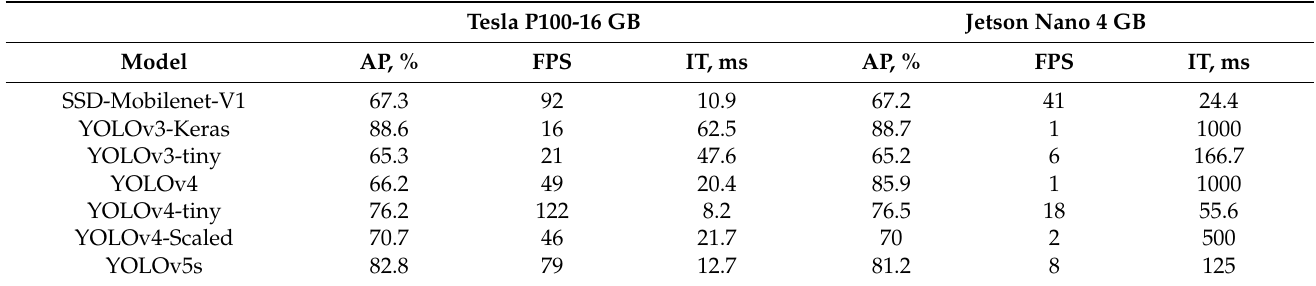
Table 4. Experimental results of investigated deep learning algorithm implementations for diode detection. Tesla P100-16